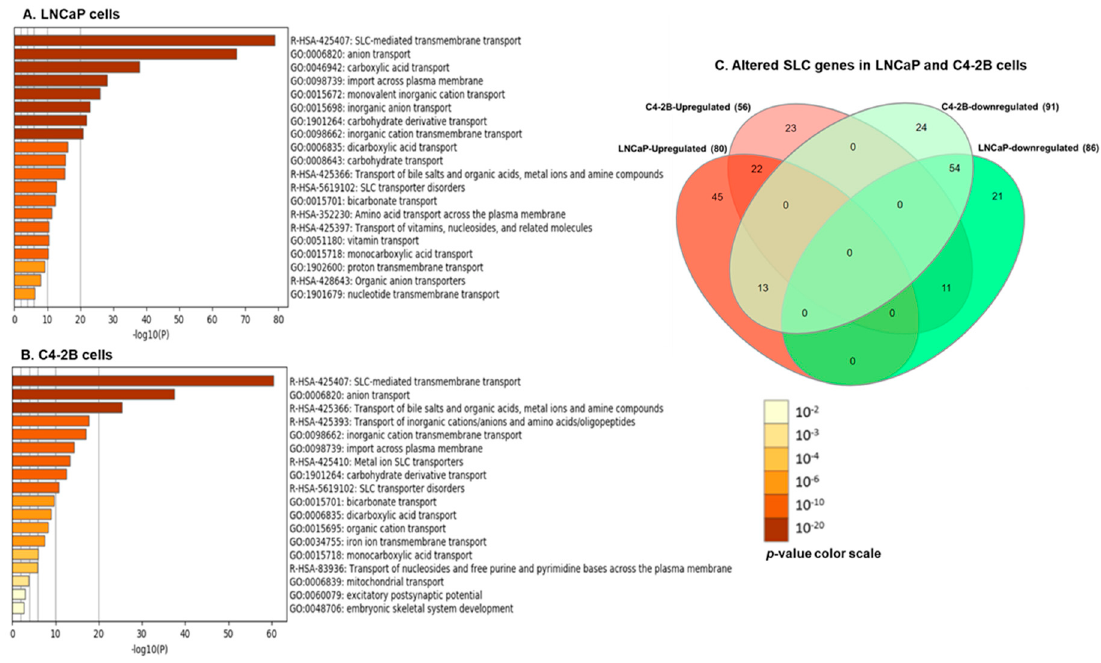
Figure 5. SLC transporter gene enrichment analysis. ( A ) LNCaP enzalutamide resistant cells ( B ) C4-2B enzalutamide resistant cells, compared to their parental counterparts at a threshold of FDR p -value < 0.05. The bar color of enrichment analysis of DEGs is displayed in both cell lines with p -values. ( C ) Venn diagram exhibiting altered SLC genes in both cell lines. The red zone represents upregulated SLCs and the green zone exhibits downregulated SLCs.